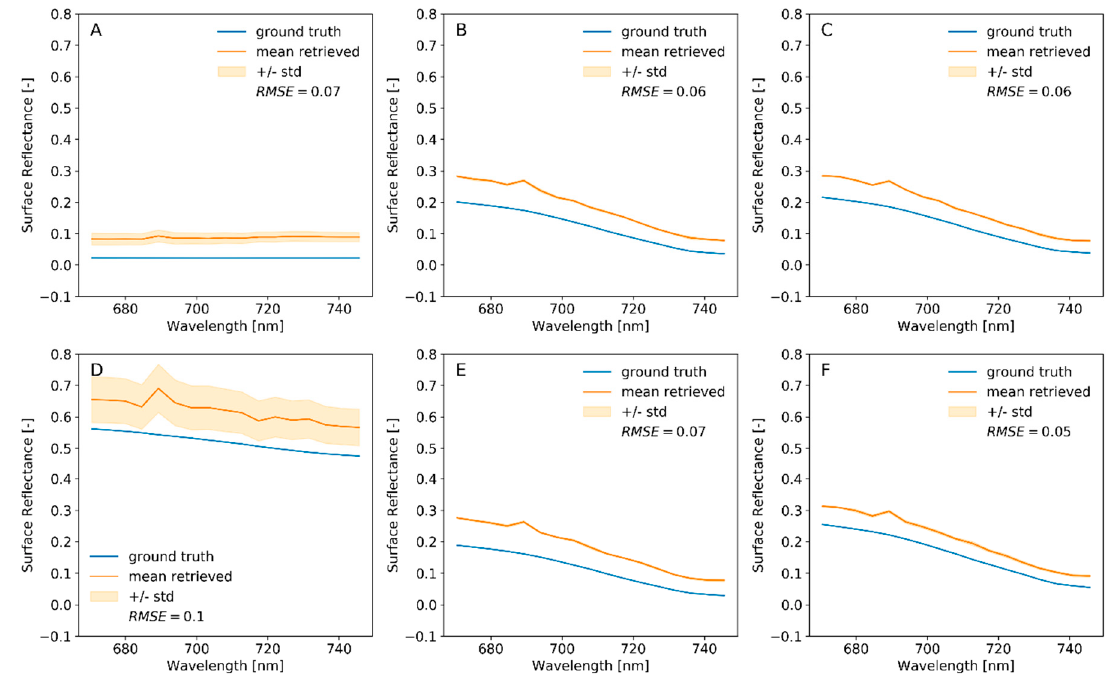
Figure 5. Comparison between ATCOR and field spectra for the dark ( A ) and bright ( D ) targets and the four melt pond bu ff ers ( B , C , E , F ). RMSE is computed for bands between 670 and 750 nm.